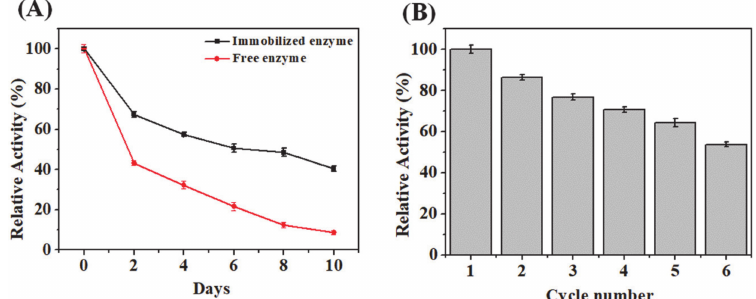
Figure 4. ( A ) Stability of the immobilized and free His-hCA II of storage stability at 25 ◦ C; ( B ) reusability of His-hCA II